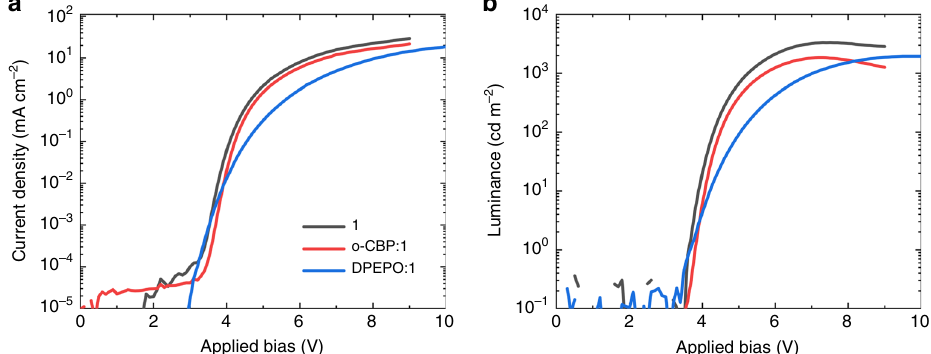
Fig. 5 Current density – voltage – luminance (J – V – L) curves. a Current density – voltage. b Luminance – voltage characteristics for OLEDs based on 1 in host- free and host-guest environments.